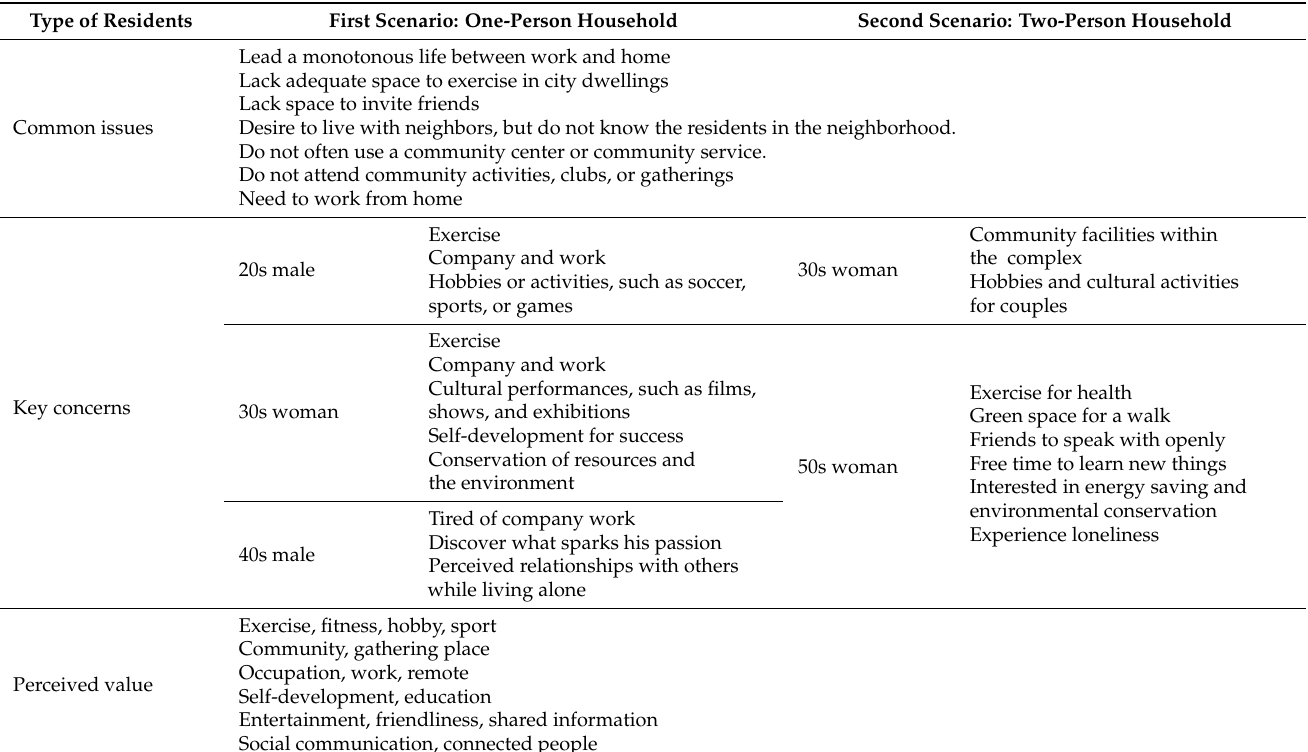
Table 8. Scenarios for One-person and Two-person